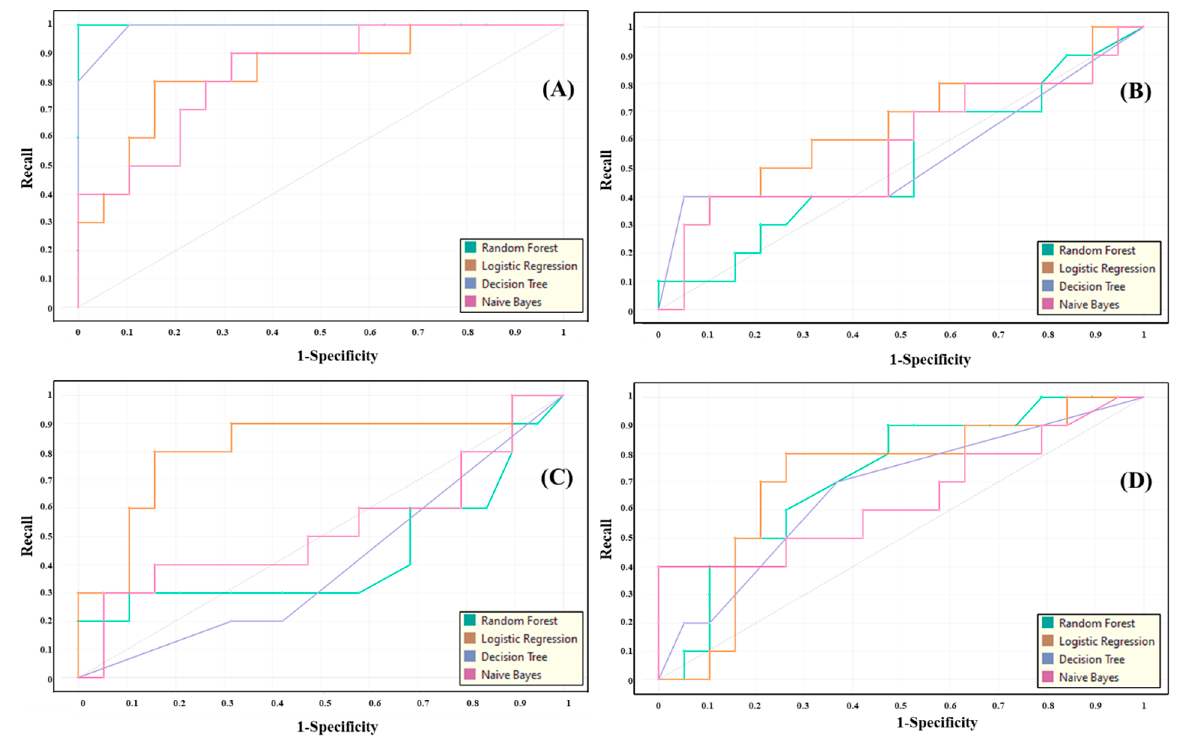
Figure 7. ROC curves of the intra-subject (mental stress and normal) classification with models such as ( A ) leave one out, ( B ) 10-fold, ( C ) 3-fold, and ( D ) 2-fold on nine features extracted by the ECG signal. Table 3. Performance of the intra-subject (mental stress and normal) classification using thirteen features, including AHR, MRR, seven HRV, and four demographic